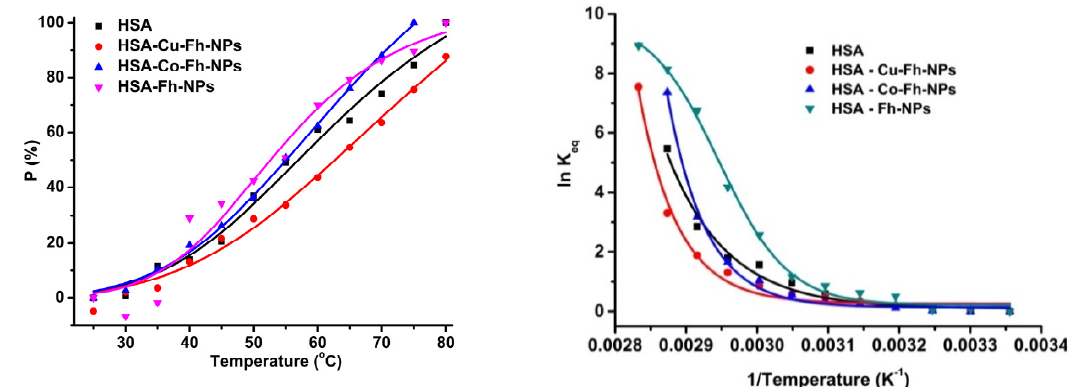
Figure 5. Percentage ( P ) of HSA denaturation as a function of temperature ( left ). Graphical representation for calculation of the HSA denaturation temperature ( right ). HSA ( ■ ), HSA-Fh-NPs ( ▼ ), HSA-Co-Fh-NPs ( ▲ ), and HSA-Cu-Fh-NPs ( ● ). HSA (2.5 µM) was dissolved in 100 mM HEPES, at pH 7.25.